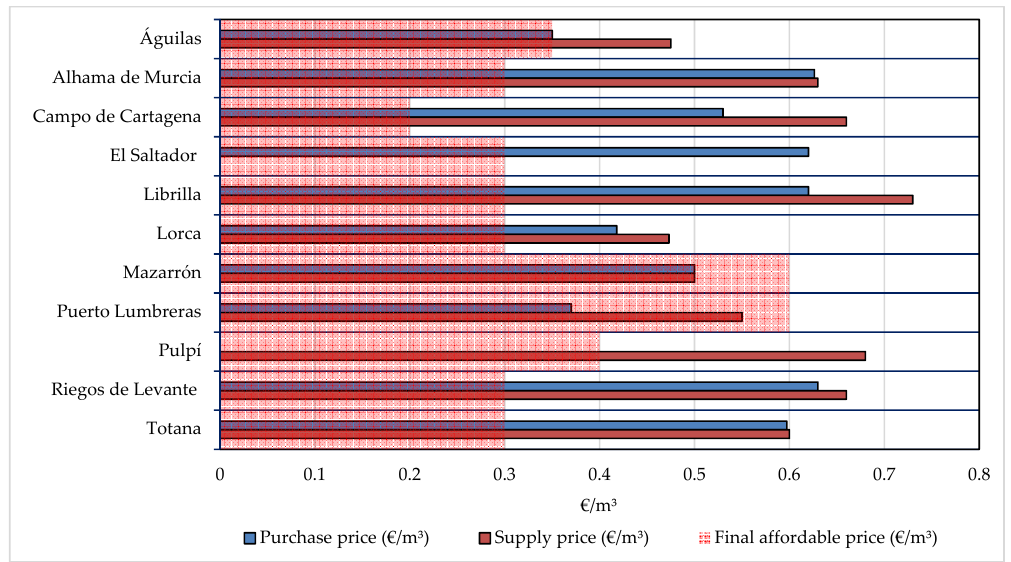
Figure 5. Purchase price, supply price and final affordable price of desalinated water by irrigation community. Source: own elaboration from the questionnaires.